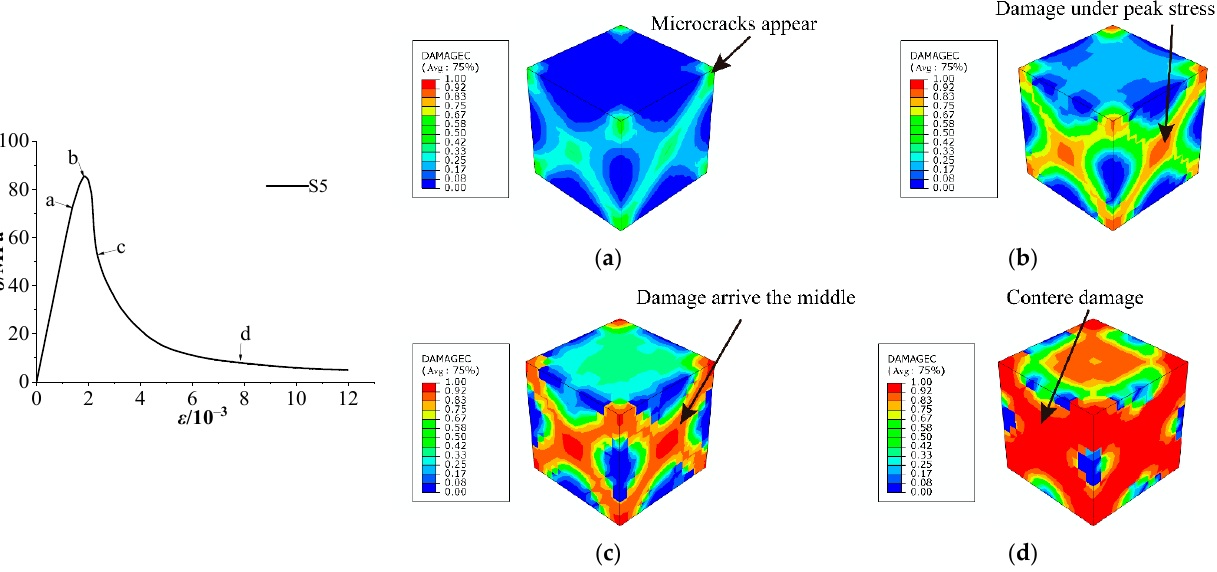
Figure 16. Cubic compression failure mode of concrete with 5% stone powder content (M1): ( a ) damage at point a, ( b ) damage at point b, ( c ) damage at point c, and ( d ) damage at point d.